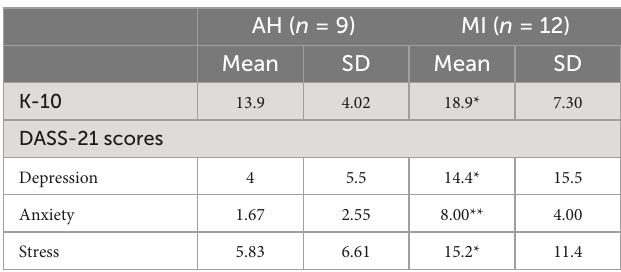
TABLE 2 Mental health characteristics of